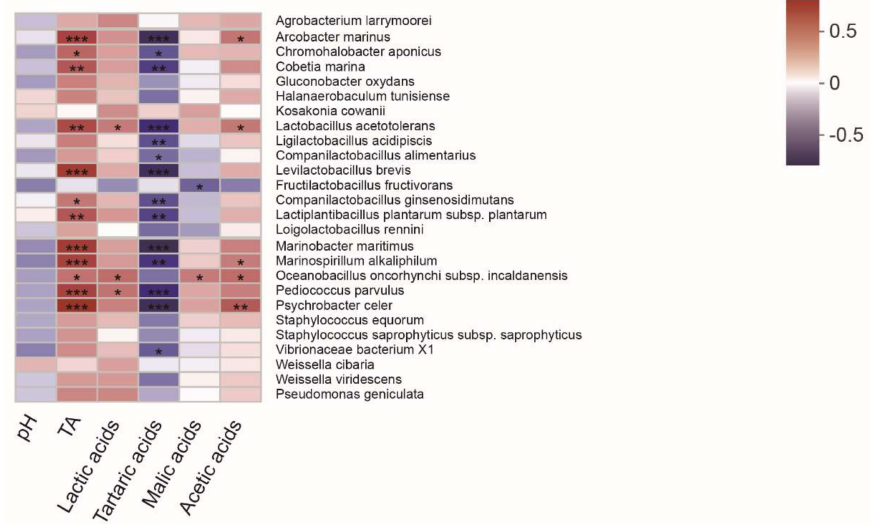
Figure 7. Spearman correlation analysis of the physicochemical index and dominant species in four traditional fermented vegetables. The Spearman correlation coefficient r ranges from − 0.5 to 0.5; r < 0 is negative correlation, r > 0 is positive correlation. * p < 0.05, ** p < 0.01, *** p < 0.001.